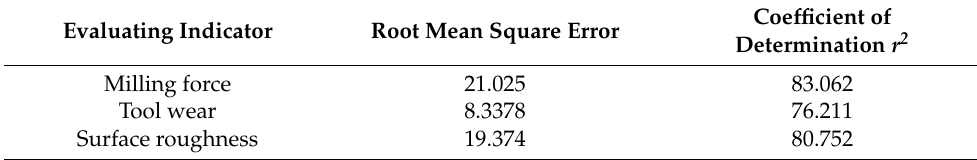
Table 5. Root mean square error and determination coefficient of neural network.